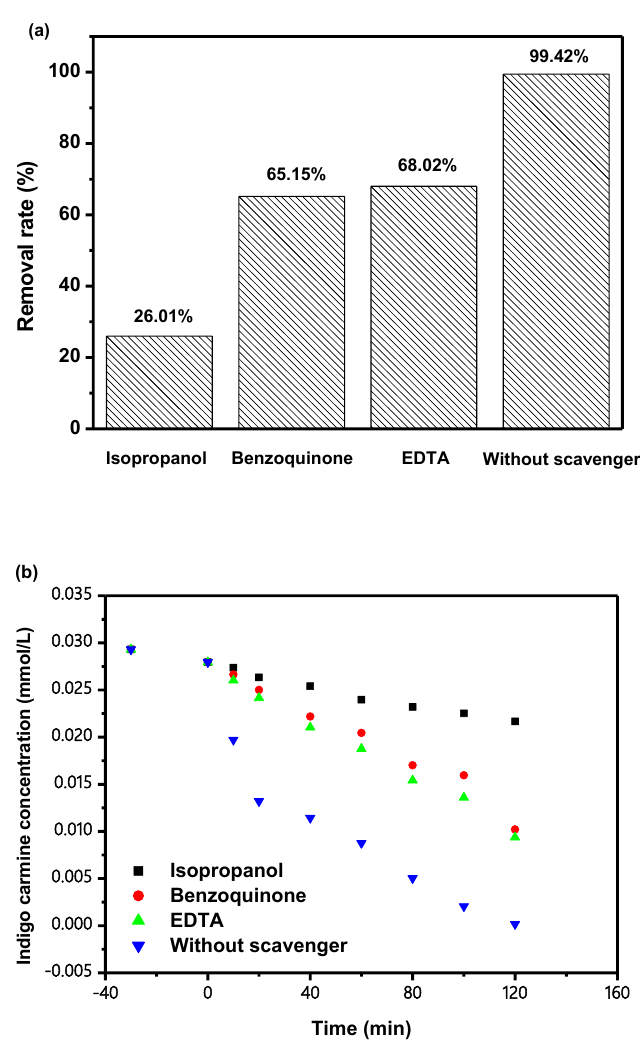
Figure 22. ( a ) Effect of different RS on ROR of IC with IBH as catalyst under VLGI; ( b ) Effect of different RS such as BQ, IPA or EDTA on the removal efficiency of IC with IBHP under VLGI.